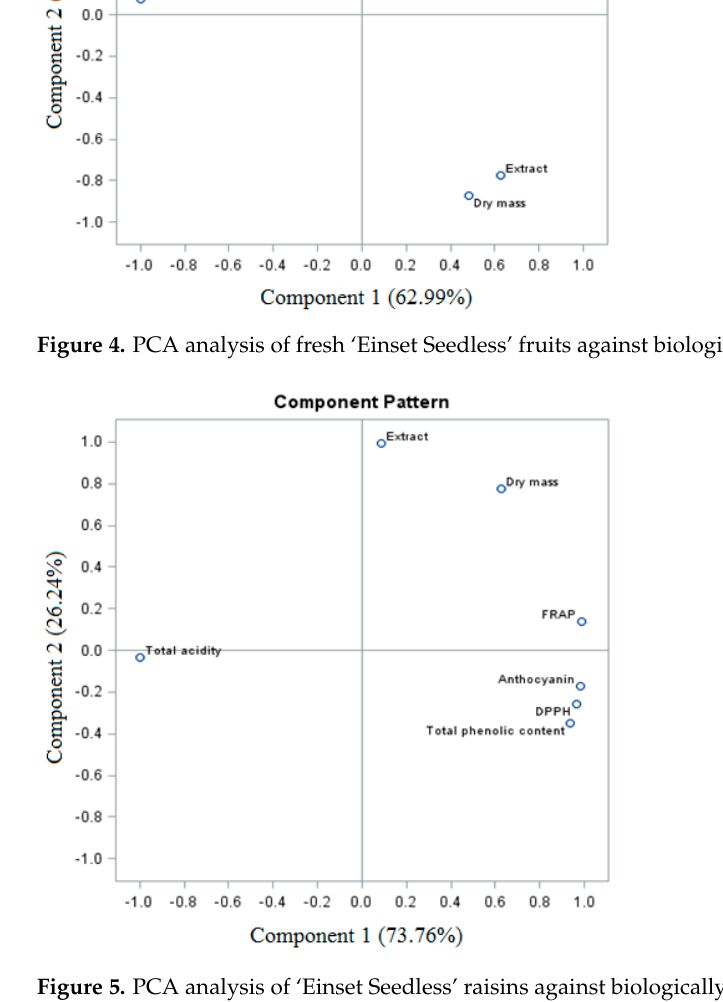
Figure 5. PCA analysis of ‘Einset Seedless’ raisins against biologically active compounds.